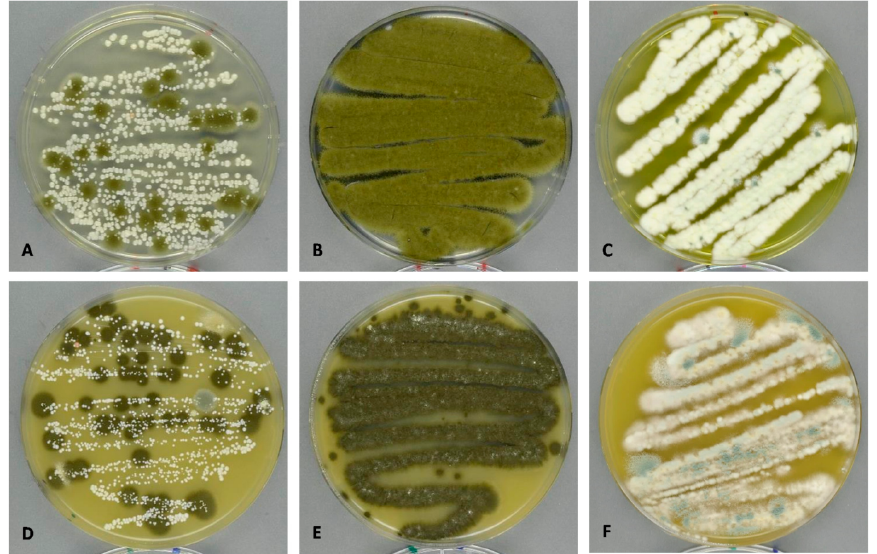
Figure 2. Culture-dependent swab samples taken after DNA swabs on H-3-G ( A , D ), H-4-Ga ( B , E ) and H-4-Gb ( C , F ) with visible growth. ( A – C ): DG18 after 7 days at 20 ◦ C and ( D – F ): V8 after 7 days at 20 ◦